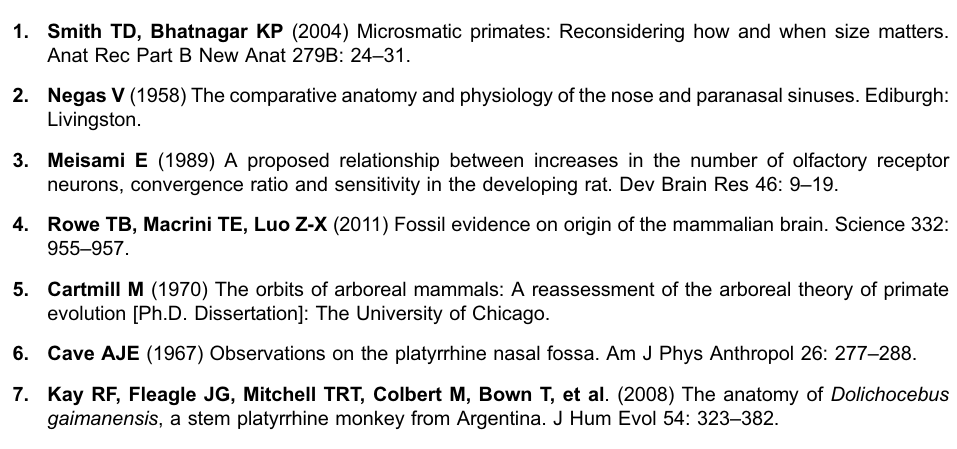
Table S2 , Maximum likelihood values of different models and likelihood ratio comparisons. Table S3 , Phylogenetic generalized least-squares model values and comparisons. Table S4 , Reconstructed ancestral nodes. Figure S6 , Ancestral reconstruction using an alternate tree. File S2. Supporting information. DNA sequence accession numbers and concatenated